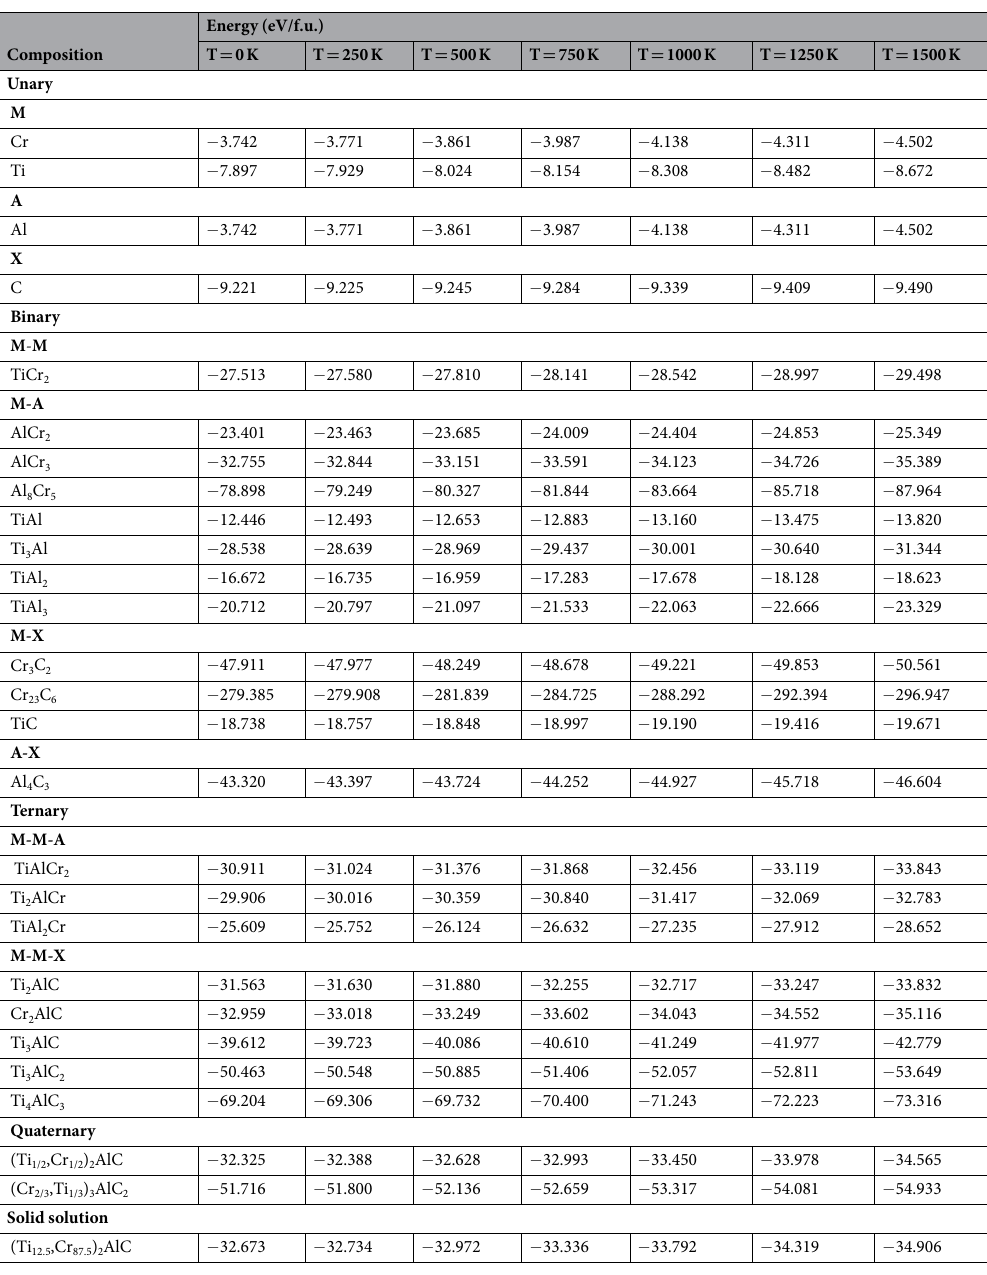
Table 2. Calculated free energies of the considered intermetallic compounds, tabulated at discrete temperatures. Here, the used potentials are PAW-PBE with the p semi-core states treated as valence